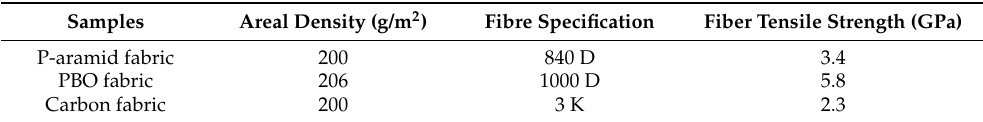
Table 3. Specification of the fabrics.